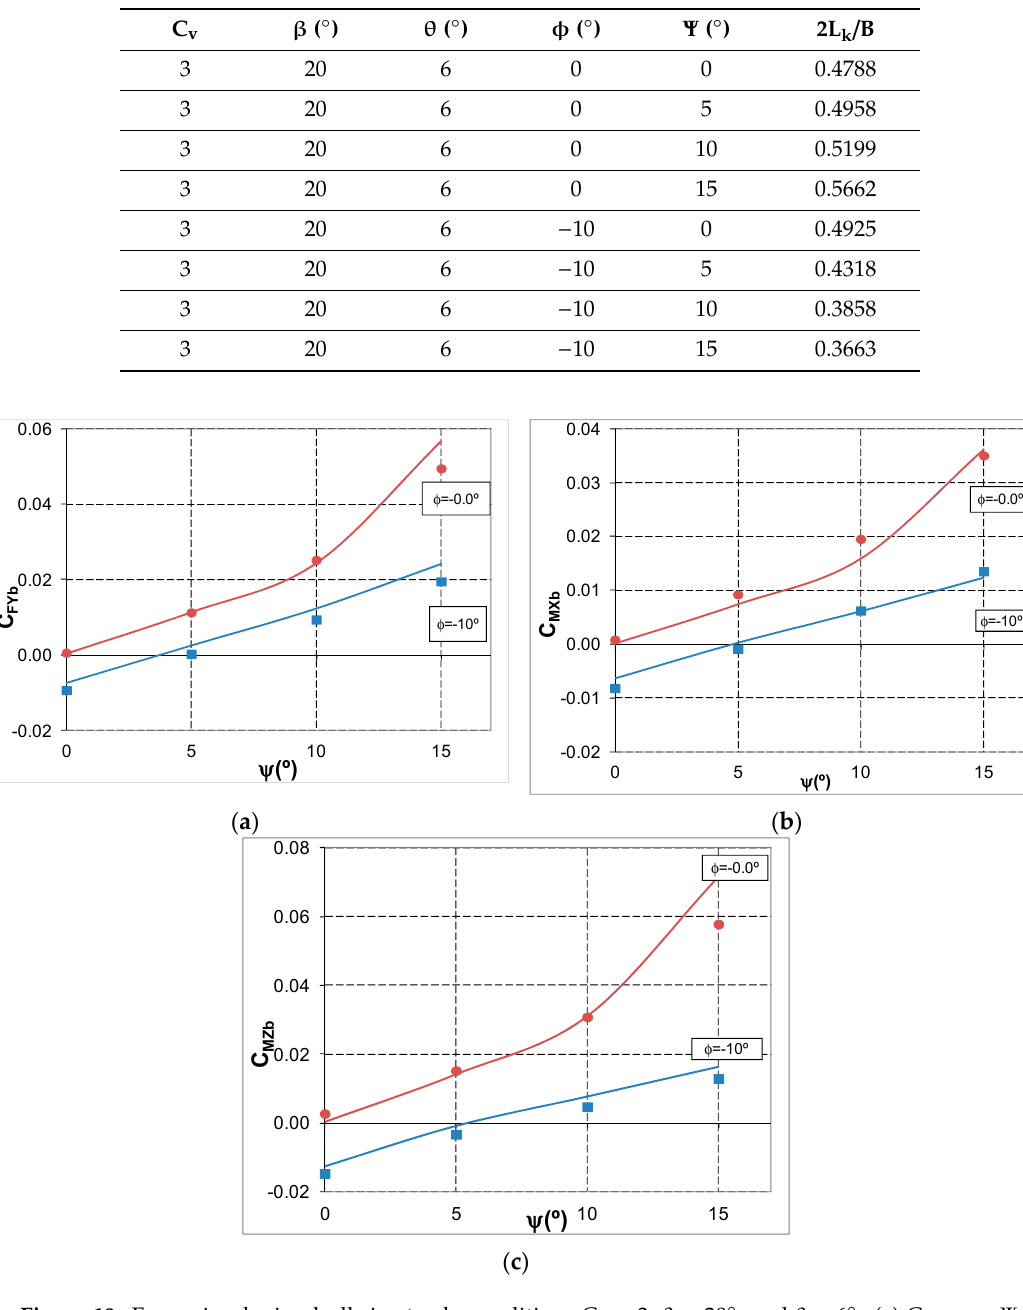
Figure 19. Forces in planing hulls in steady conditions C v = 3, β = 20°, and θ = 6°. ( a ) C FYb vs. Ψ . ( b ) C MXb vs. Ψ . ( c ) C MZb vs. Ψ . ( ⎯ , ⎯ )Current formulation, ( • , ▪ ) Brown and Klosinsky [28] Table 2. Experimental conditions by Brown and Klosinsky [28].